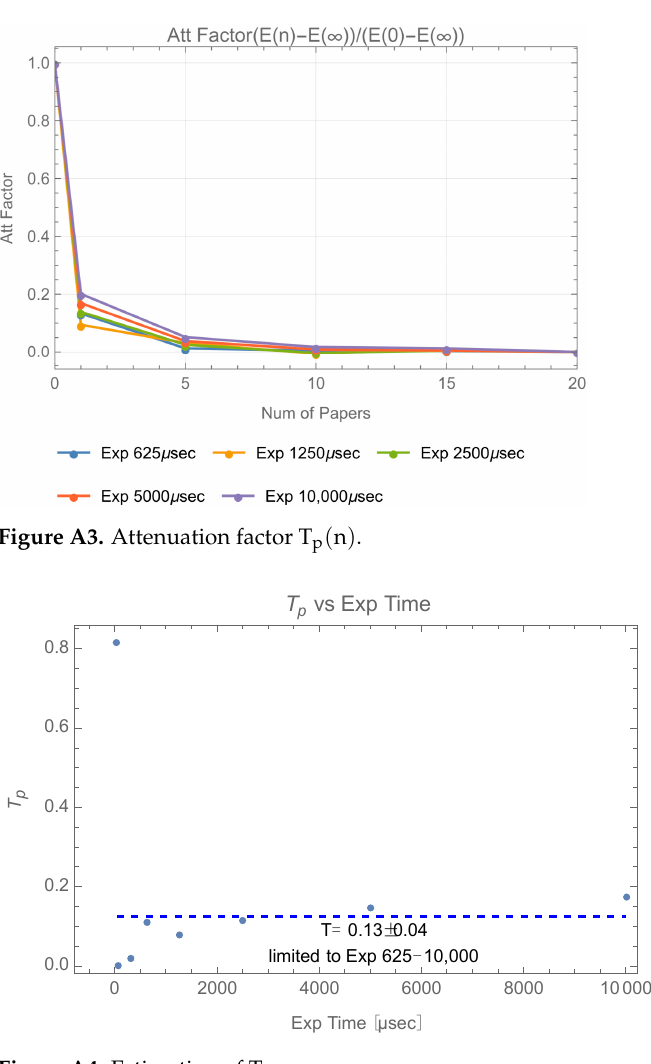
Figure A4. Estimation of T p